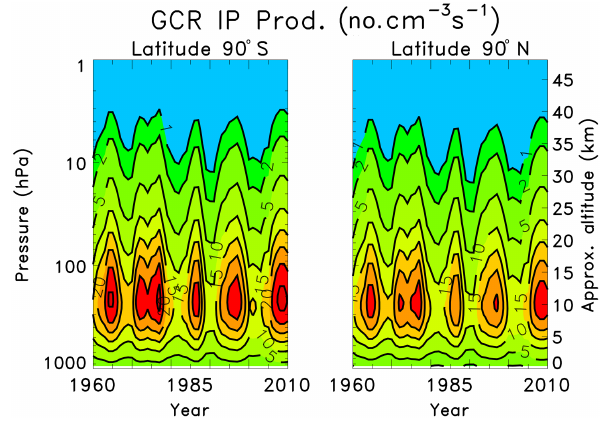
Figure 2. NAIRAS model computed galactic cosmic ray annual av- erage ionization rates at 90 ◦ S (left) and 90 ◦ N (right) over the time period 1960–2010. Contour intervals are 1, 2, 5, 10, 15, 20, 25, and 30 (#cm − 3 s − 1 ) .